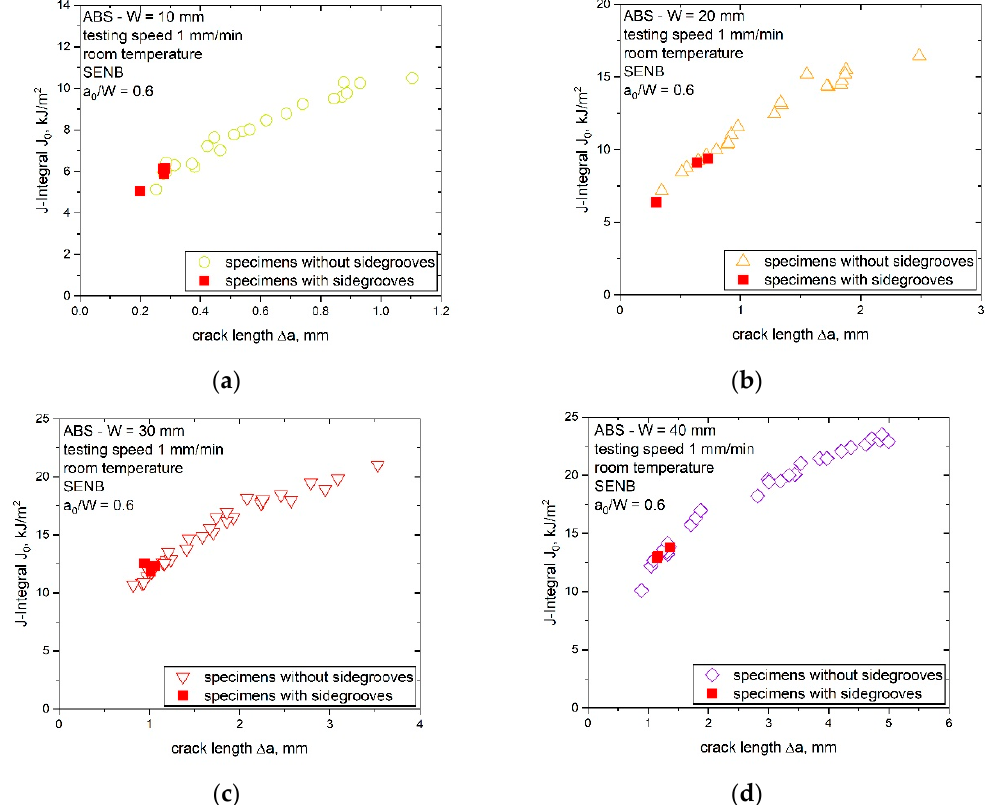
Figure 12. Resulting J–R curves of specimens tested with and without side grooves for increasing specimen sizes (W is 10 mm ( a ), 20 mm ( b ), 30 mm ( c ) and 40 mm ( d ), data points adapted from [7] with permission).